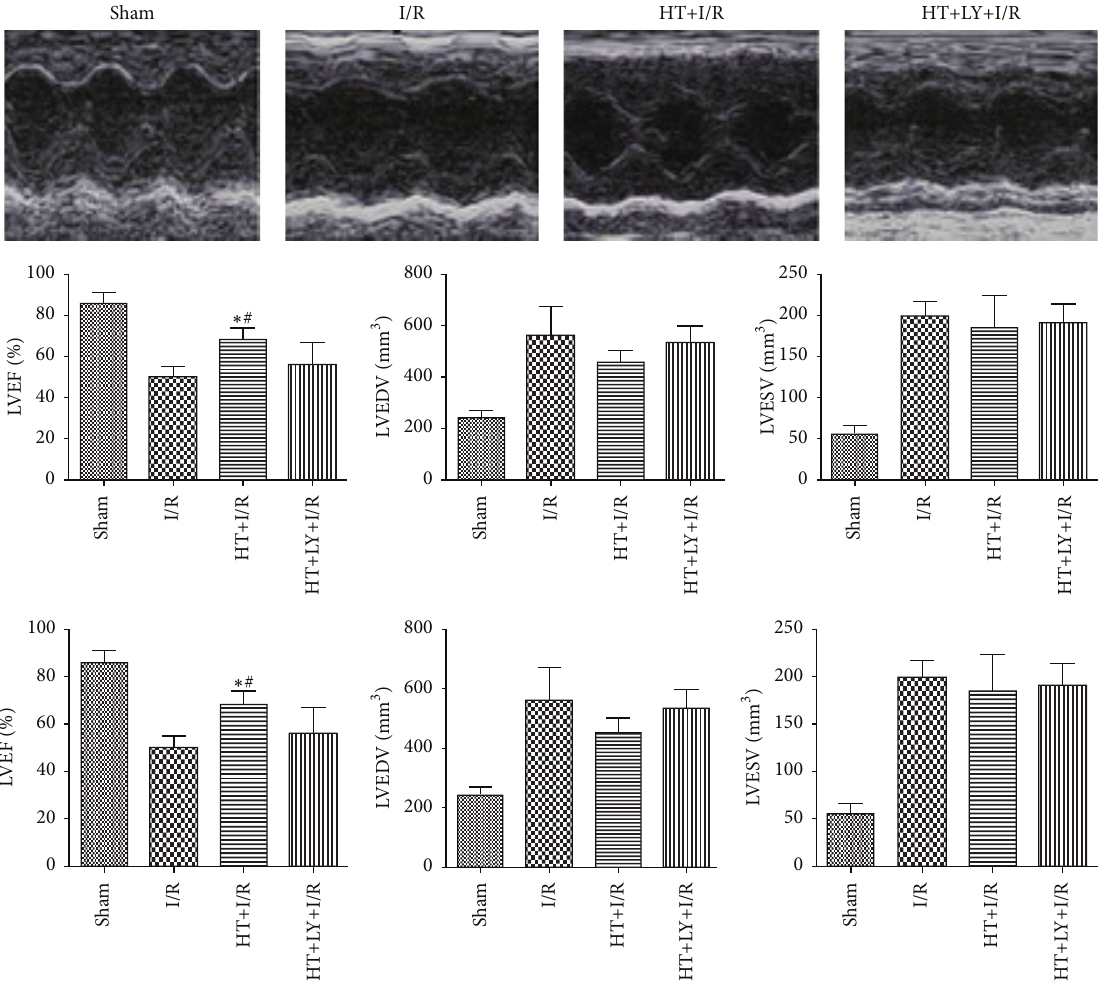
Figure 6: Echocardiography was conducted at two time points: 30 min before surgery to obtain baseline data and 72 h after reperfusion ( 𝑛 = 4 for each group). Representative images of echocardiographic examination showed that the HT group has better left ventricular free wall motion compared with the I/R group and the HT+LY+I/R group. HT administration significantly enhanced LVEF as compared with that in the I/R group and HT+LY+I/R group. ∗ 𝑃 < 0.05 versus I/R group. # 𝑃 < 0.05 versus HT+LY+I/R